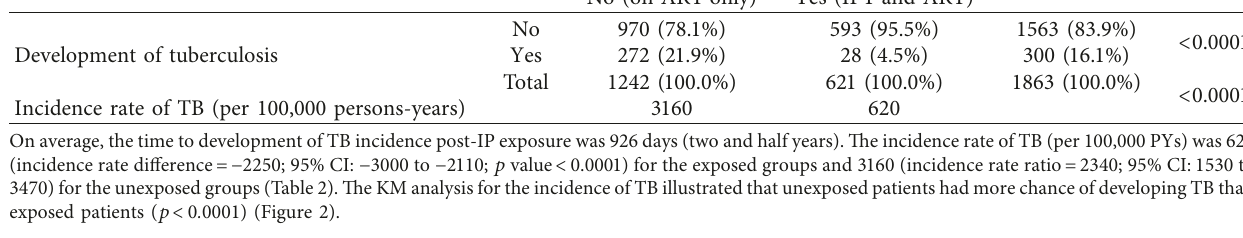
Table 2: Incidence of tuberculosis among patients living with HIV/AIDS taking IPT and ART versus ART alone in Northern Ethiopia, 2009–2017.